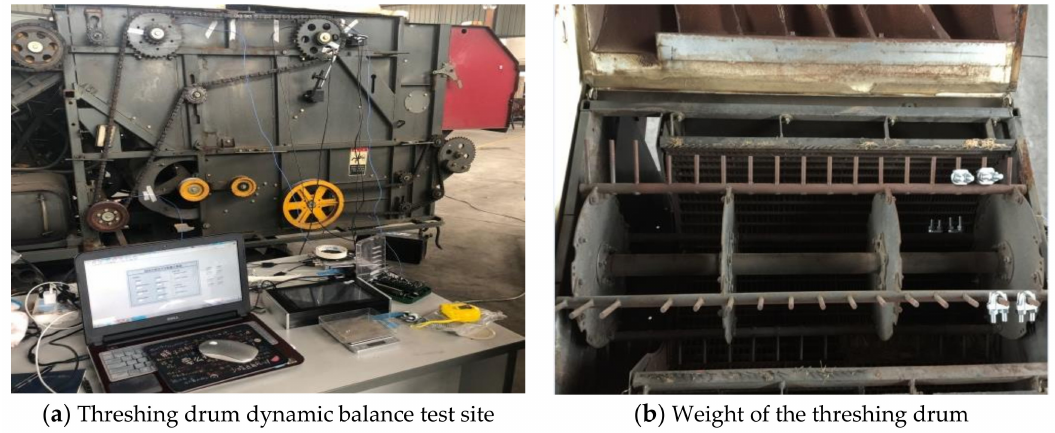
Figure 5. Word Dragon’s double threshing drums combine